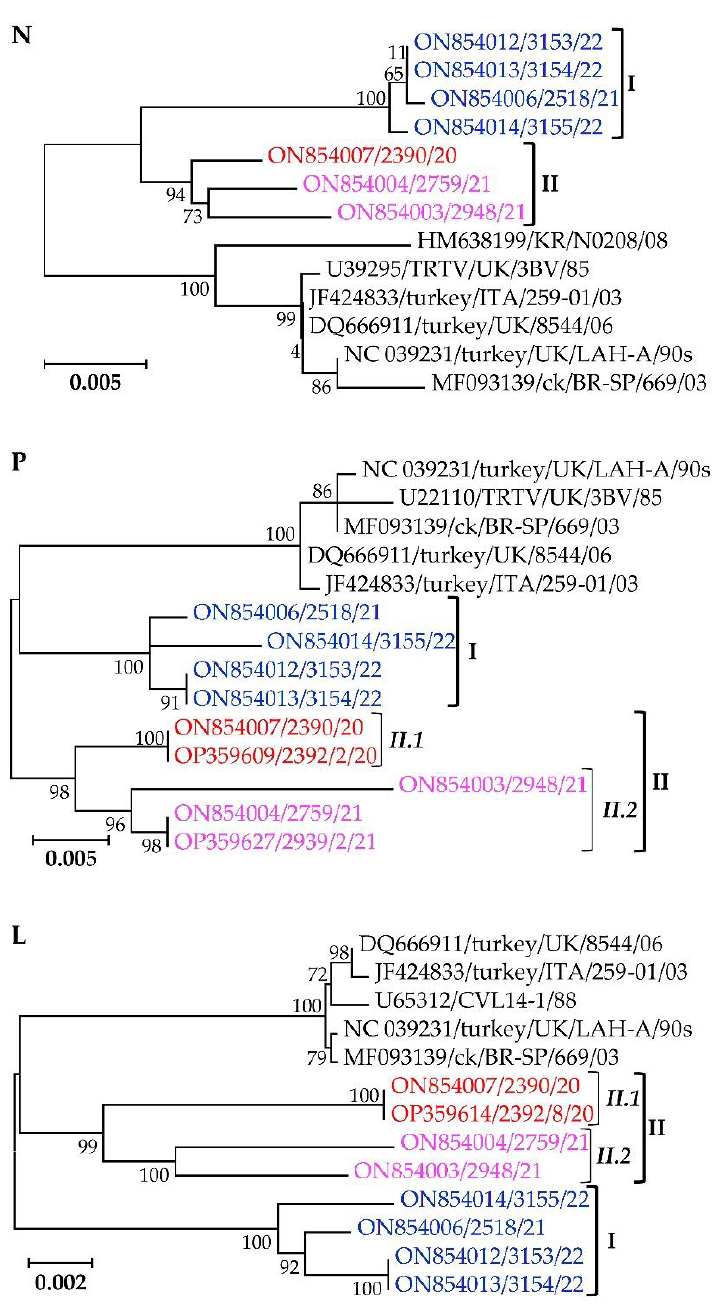
Figure 6. Phylogenetic trees of the components of pneumovirus ribonucleoprotein complex (nucleocapsid (N), phosphoprotein (P), and large polymerase (L) proteins) of the Mexican aMPV-A isolates identified in the current study and Eurasian and Brazilian aMPV-A strains. Isolate/strain names include GenBank accession number, avian species, country, and year of sample collection.